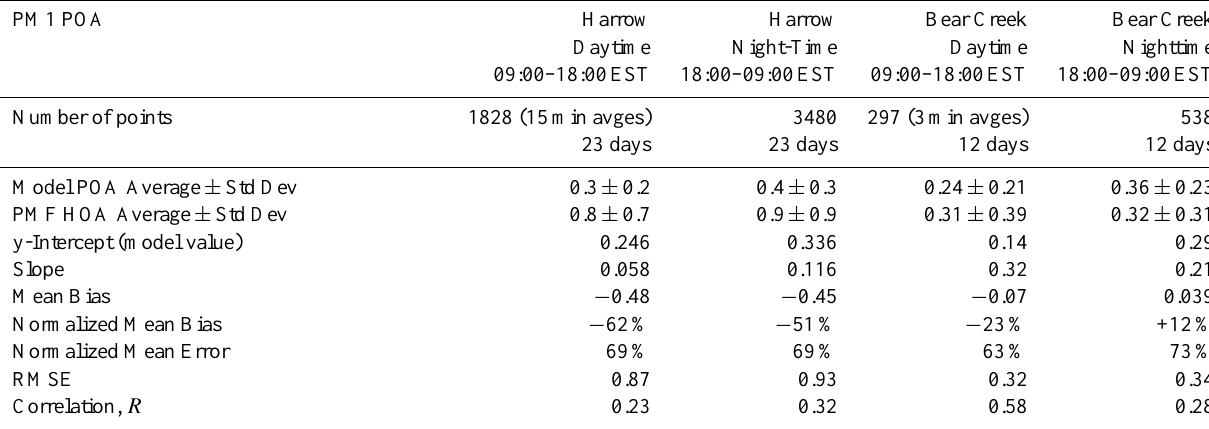
Table 7. AURAMS PM 1 POA model performance statistics for the 2.5-km grid for the rural Harrow and Bear Creek sites (concentrations in µgm − 3 ) .